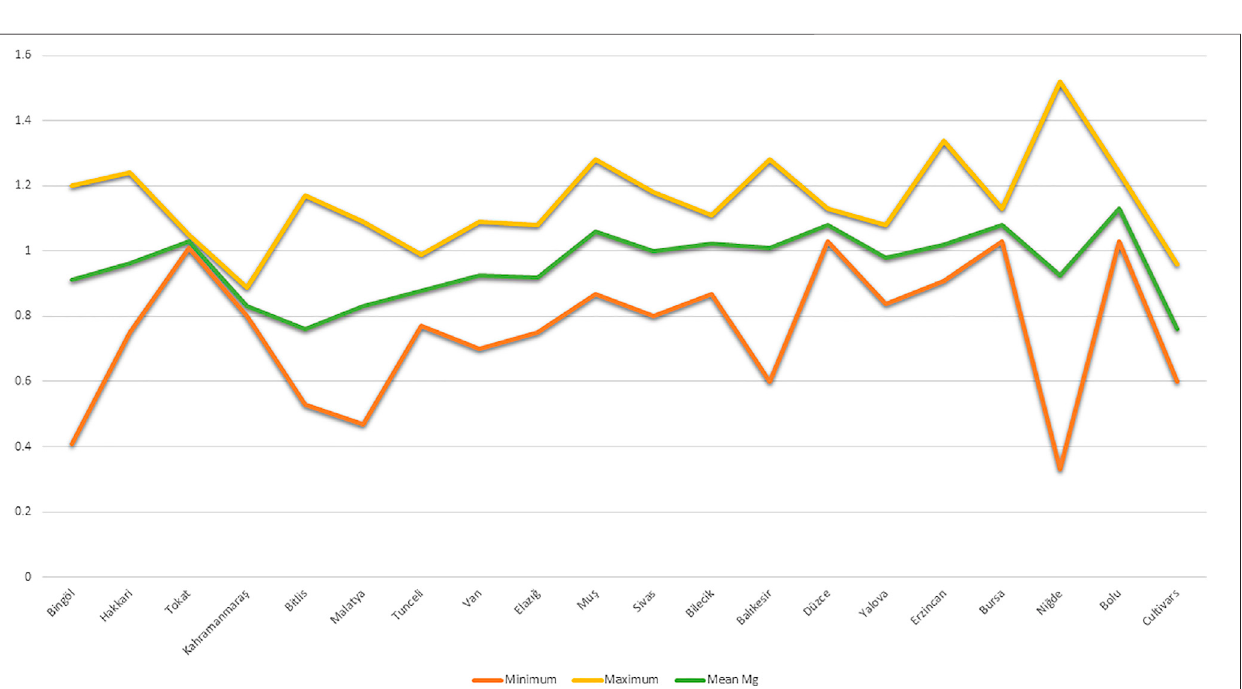
FIGURE 2 | Variation of seed Mg contents in Turkish common bean germplasm on the basis of their collection provinces.